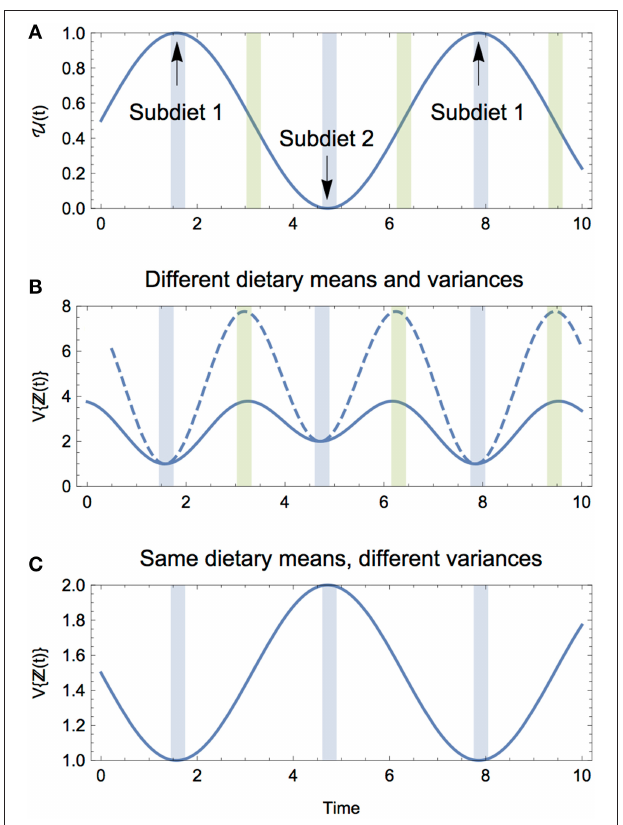
FIGURE 3 | (A) The proportional contribution of Diet 1 to the composite diet Z Z ( t ) over time. (B) The isotopic variance of the composite diet V when { } subdiets 1 and 2 have different means and variances. Two examples are shown: one where the dietary means are closer in isotopic space (solid), and one where the dietary means are farther apart (dashed). For both, the peak variance occurs during the dietary transitions (green shading), whereas the troughs reflect the variances of subdiet 1 and 2, respectively (blue shading). Z ( t ) (C) The isotopic variance of the composite diet V when subdiets 1 and 2 { } have the same means but different variances. When the subdiets have the Z ( t ) same means, V oscillates to reflect the respective variances of the { } subdiets, and does not exhibit peak variance during the dietary transition.